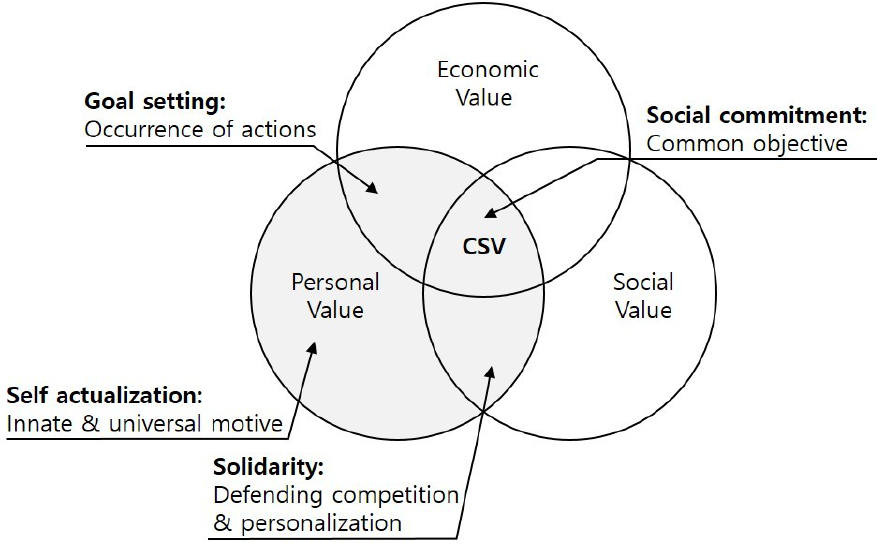
Figure 2. Factors of Personal Value.